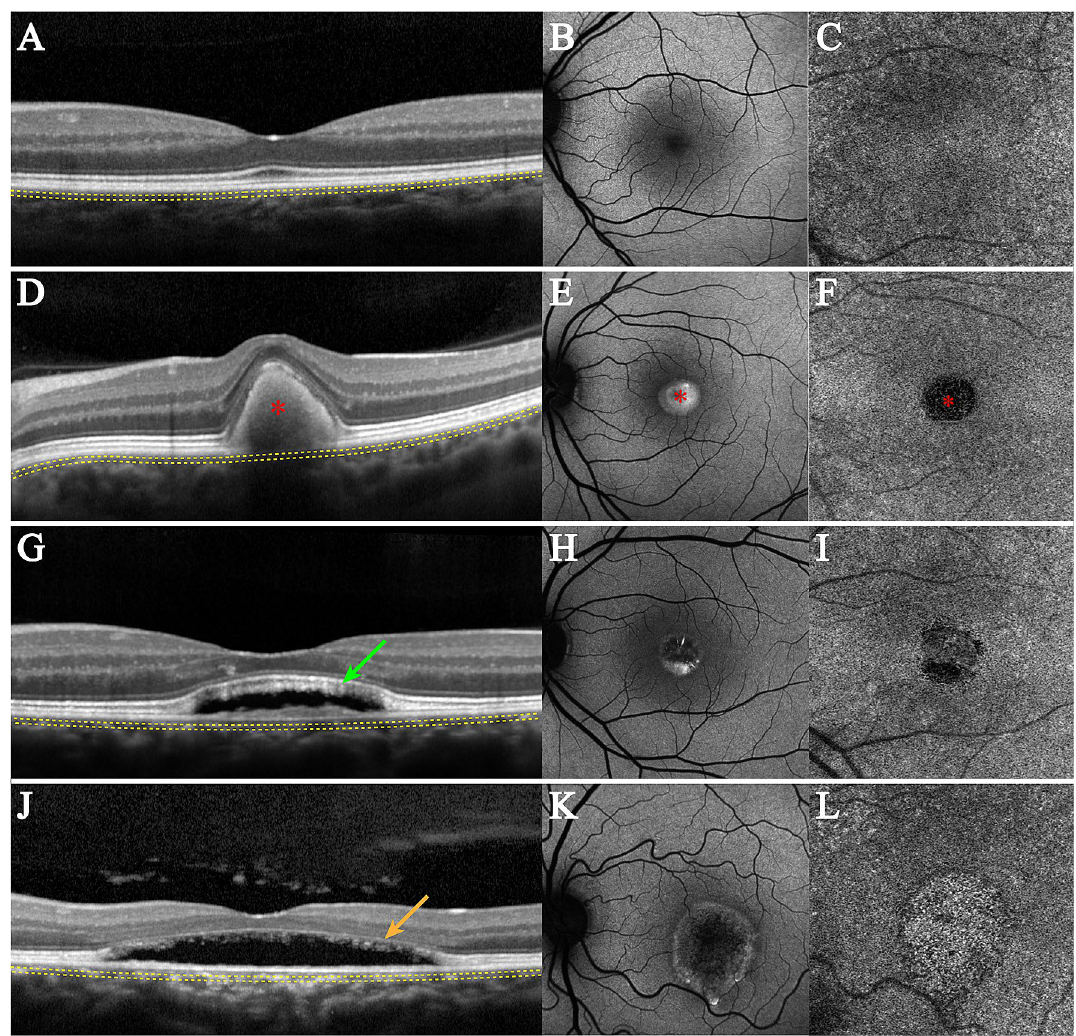
Figure 1. Multimodal imaging of eyes at the previtelliform, vitelliform, pseudohypopyon, and vitelliruptive stages. At the previtelliform stage, spectral-domain optical coherence tomography (SD-OCT) images revealed intact retinal layers ( A ). Short-wavelength fundus autofluorescence (SW-AF) images demonstrated macular hypoautofluorescence (hypoAF) while images of the choriocapillaris (CC) by optical coherence tomography angiography (OCTA) demonstrated a homogenous pattern, both as observed in healthy eyes ( B , C ). At the vitelliform stage, a hyperreflective material (red asterisk) is observed in SD-OCT images ( D ). This material is hyperautofluorescent (hyperAF) in SW-AF images ( E ) and obstructs the OCTA signal, causing the area to appear as dark and devoid of CC ( F ). The eyes at the pseudohypopyon stage presented with hyporeflective subretinal fluid and a thickened interdigitation zone (IZ) band with abnormal reflectance (green arrow) in SD-OCT images ( G ). On SW-AF images, patchy hypoAF was observed in the macula, with inferior displacement of the hyperAF material ( H ). The CC corresponding to the lesion area appeared heterogeneous, with regions where the CC was visible and regions where it was not ( I ). Eyes at the vitelliruptive stage also presented with hyporeflective fluid on SD-OCT images, but the IZ band appeared as fragmented, with the remaining outer segments appearing in clumps (orange arrow) ( J ). SW-AF images revealed macular hypoAF, whereas the CC appeared granular and bright on OCTA images ( K , L ). The yellow dashed lines on the SD-OCT images represent the approximate location of the CC the progressive hypoAF of the lesion area in SW-AF images. Although no obvious CC atrophy is observed in the vitelliruptive stage, the increased CC granularity in the lesion area suggests the beginning of morphologic changes and possible impairment. In the atrophic stage, the lesion area appeared as densely hypoAF in SW-AF images, indicating RPE atrophy. In the eyes where hyporeflective fluid was visible in SD-OCT scans, the lesion area was not as densely hypoAF as compared to the eyes where the outer retinal layers have atrophied and inner retinal layers subsequently collapsed. This presentation parallels the findings in OCTA images. In those patients with remaining hyporeflective fluid, CC atrophy was observed as patchy, but in the patients with collapse of the inner retinal layers and dense hypoAF, CC atrophy was more severe to the extent that the underlying choroidal vasculature was visible. Despite being classified as eyes in the atrophic stage, we suggest that those eyes with